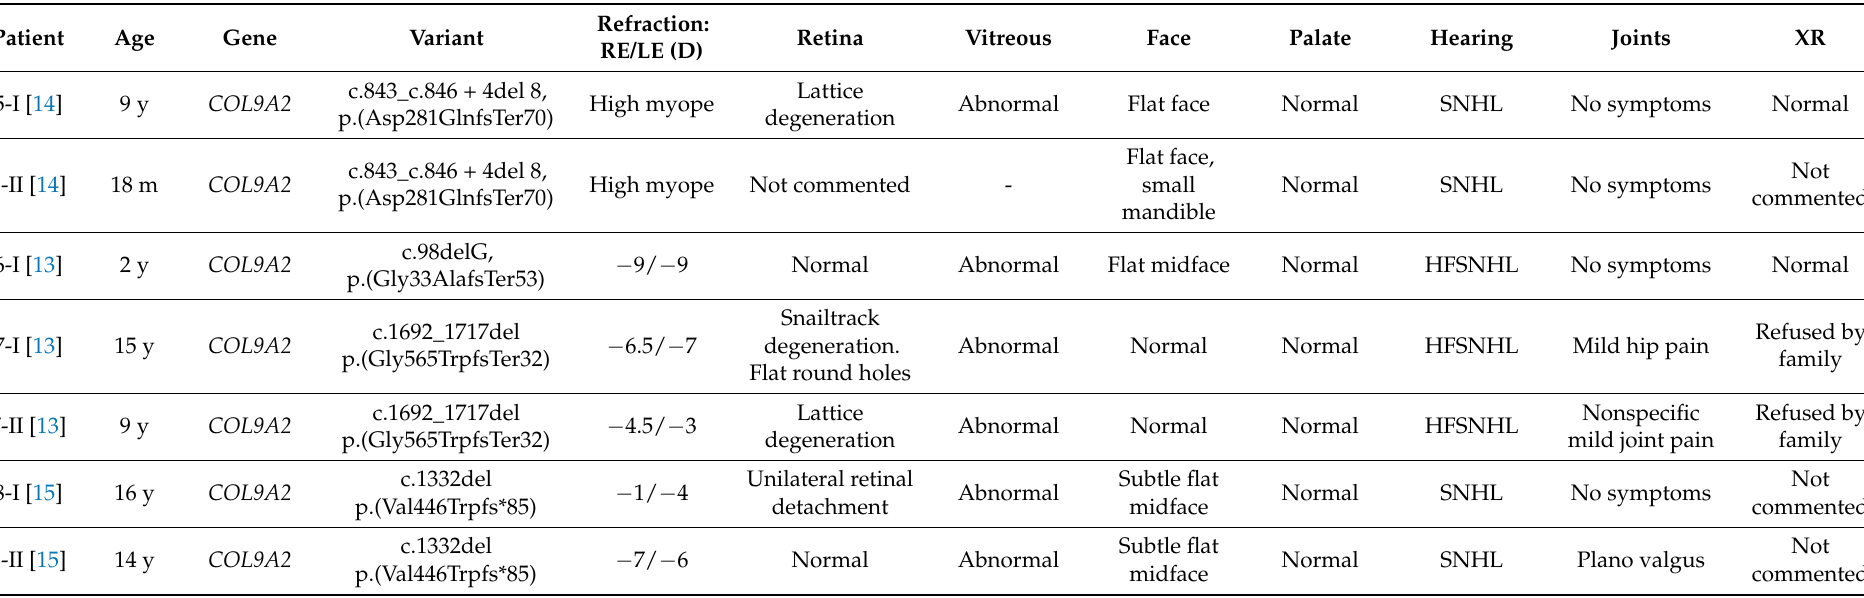
Table 2. Clinical features of patients with recessive pathogenic variants in COL9A2 . All variants mentioned are homozygous in the affected patient.